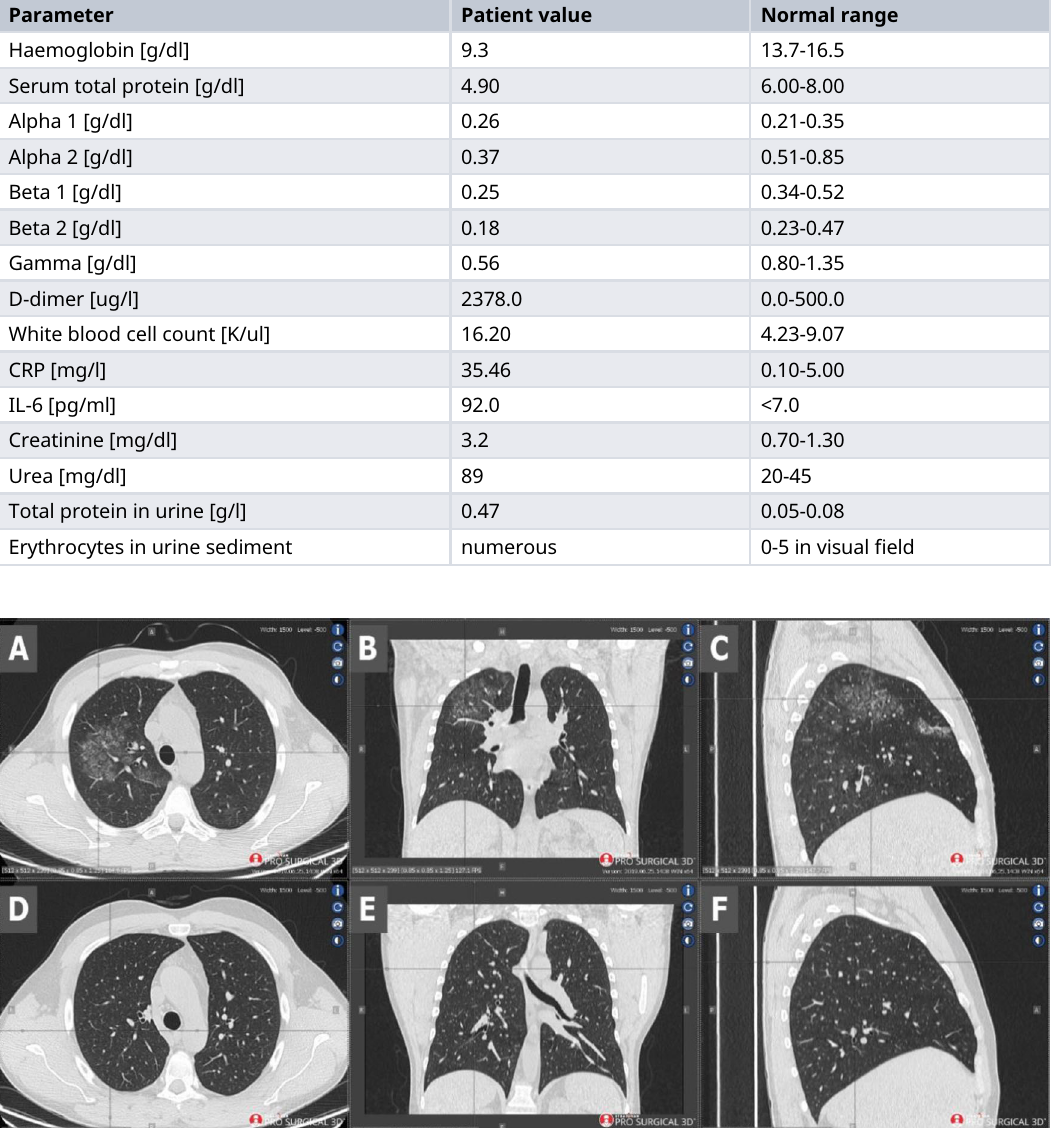
Table 1. Patient ’ s laboratory results on admission.